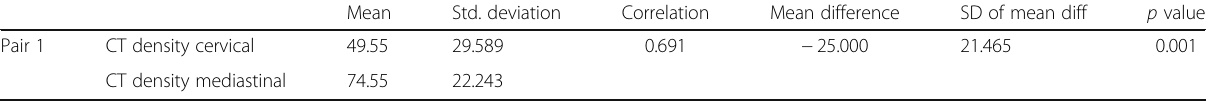
Table 1 Comparison of CT densities of cervical and mediastinal parts of thymus by paired t test Mean Std. deviation